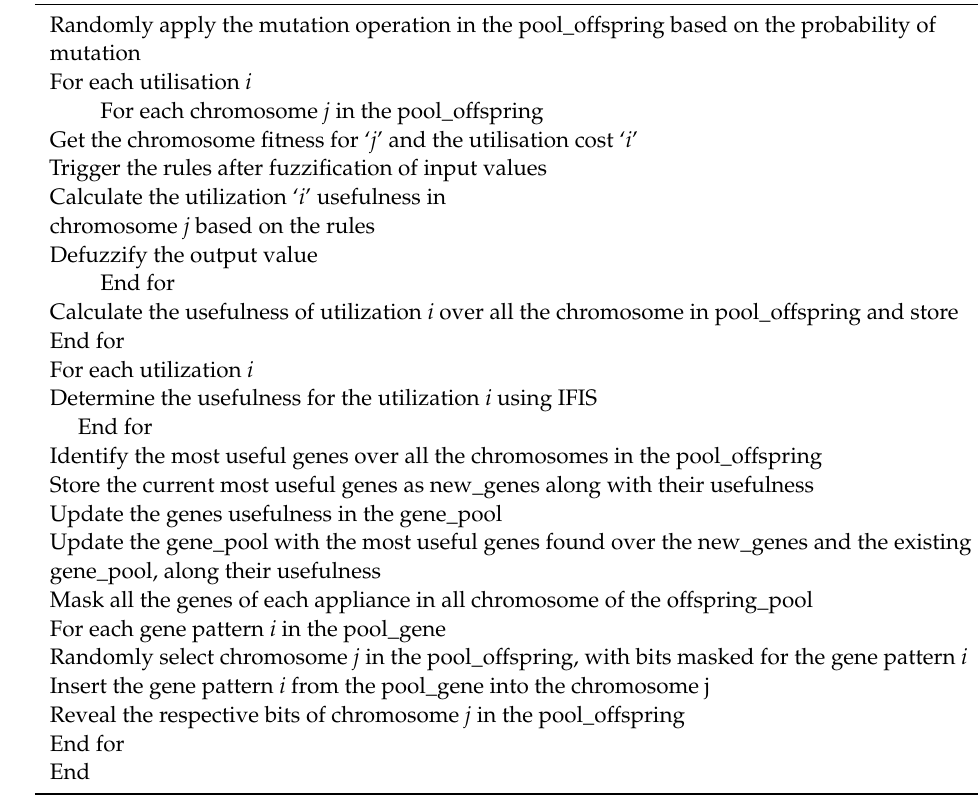
Algorithm A2. Pseudocode of GA block